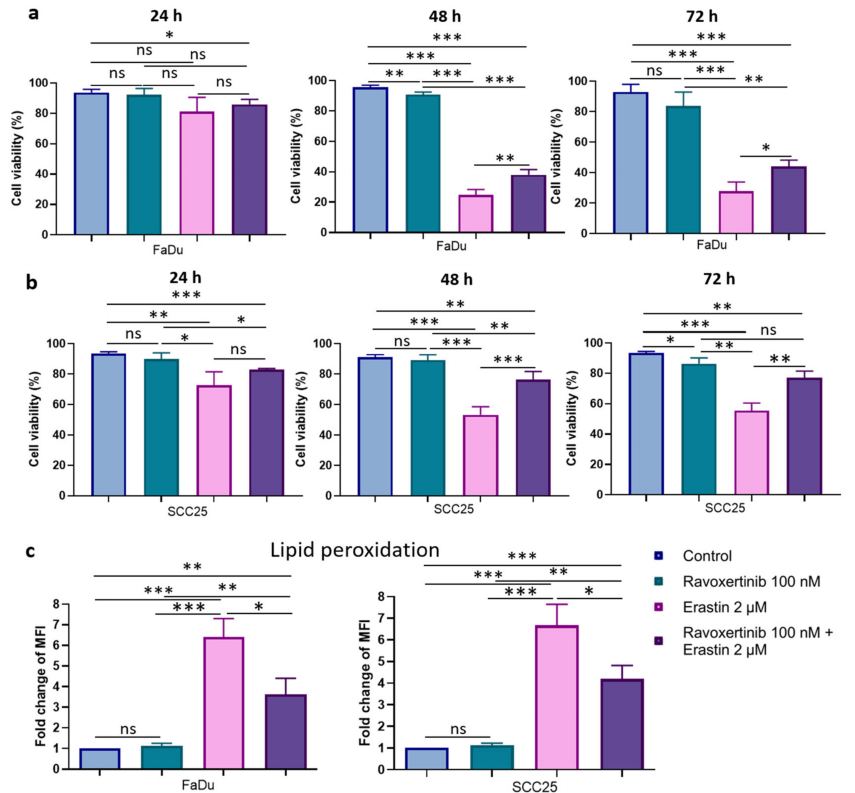
Figure 6. Cell viability and lipid peroxidation in FaDu and SCC25 HNSCC cells in response to erastin and ravoxertinib exposure. FaDu ( a ) and SCC25 ( b ) cells were treated with erastin (2 µ M), ravoxertinib (100 nM), or their combination, and cell viability was detected at 24, 48, and 72 h, as described in Materials and Methods. Lipid peroxidation was studied via flow cytometry analysis of the oxidized C11-BODIPY (581/591) in HNSCC cells at 24 h after treatment with erastin (2 µ M), ravoxertinib (100 nM), or their combination ( c ). Data are given as mean + SD ( a , b ) or mean + SEM ( c